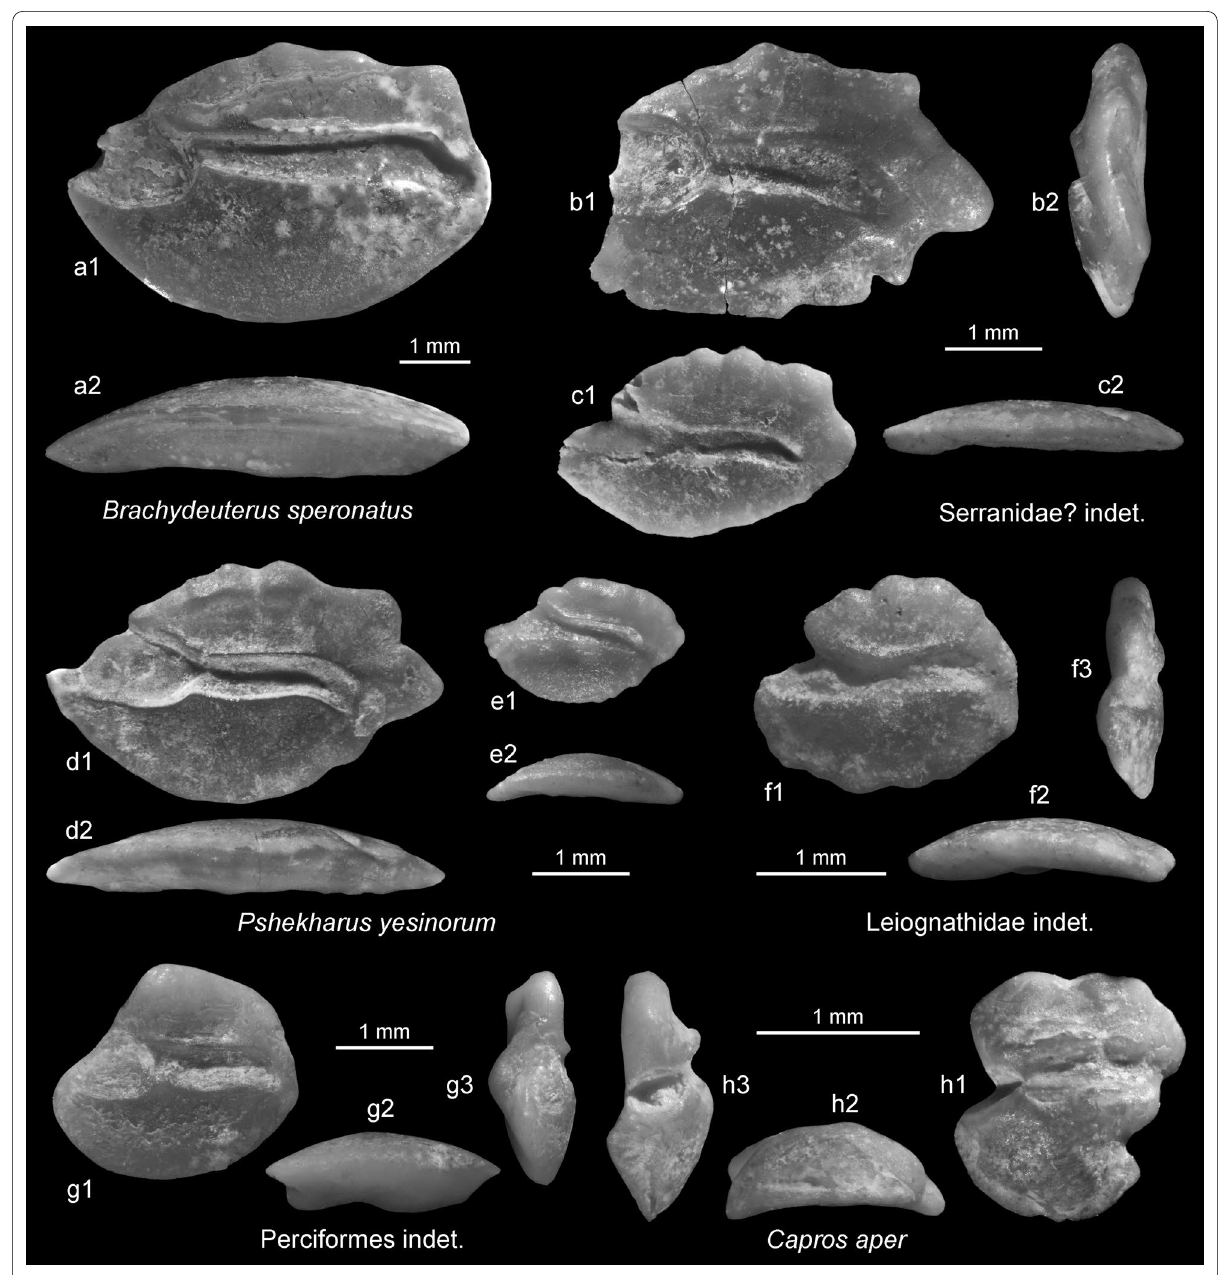
Fig. 9 Otoliths of Haemulidae, Serranidae, Sparidae, Leiognathidae and Caproidae: a (reversed)— Brachydeuterus speronatus (Bassoli, 1906), Kozatskyi Yar, NMNHU-P PI 2549. b , c Serranidae indet., b (broken and repaired), c (reversed), Kozatskyi Yar, NMNHU-P PI 2579. d , e Pshekharus yesinorum Bannikov & Kotlyar, 2015, Mlyntsi, NMNHU-P PI 2578. f (reversed)—Leiognathidae indet., Shydlivshchyna, NMB P1214. g Perciformes indet., Shydlivshchyna, NMB P1221. h (reversed) – Capros aper (Linnaeus, 1758), Mlyntsi, NMB